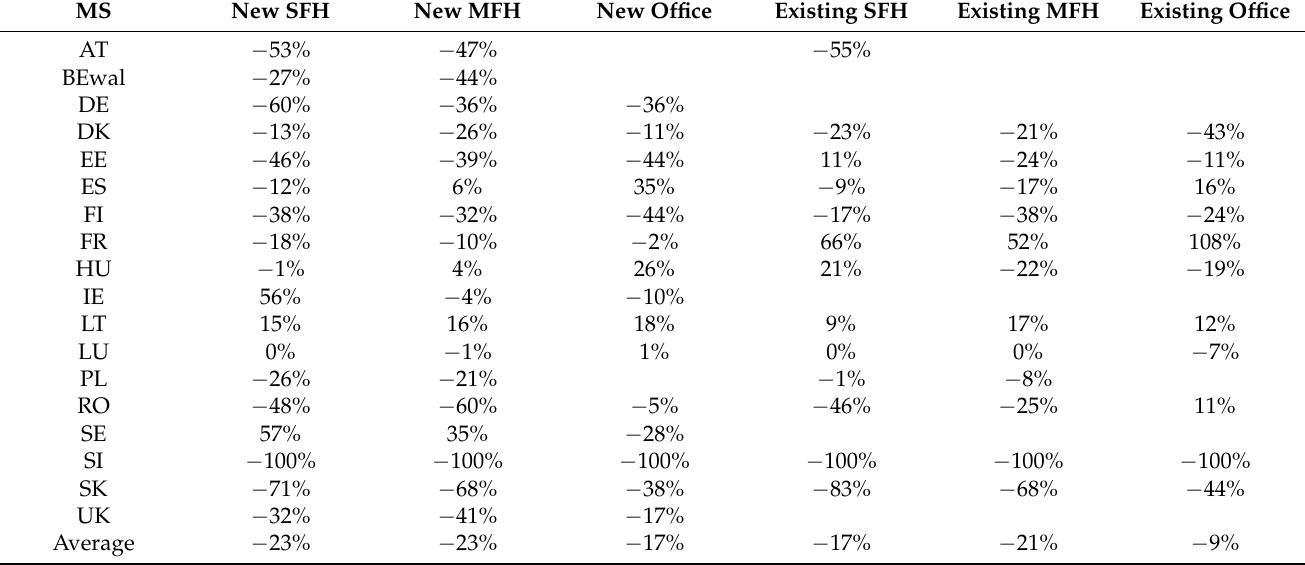
Table 6. Comparison between cost-optimal levels obtained Member States in 2020 and 2013.